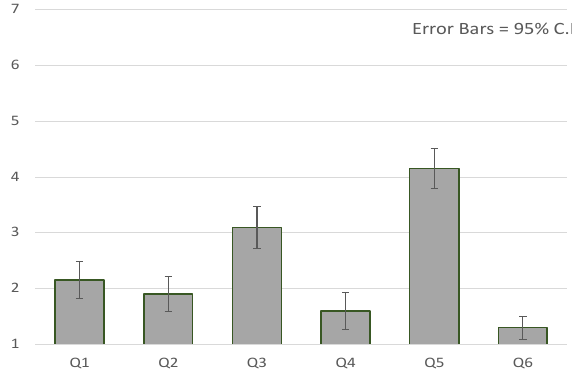
Figure 8: Final feedback questionnaire